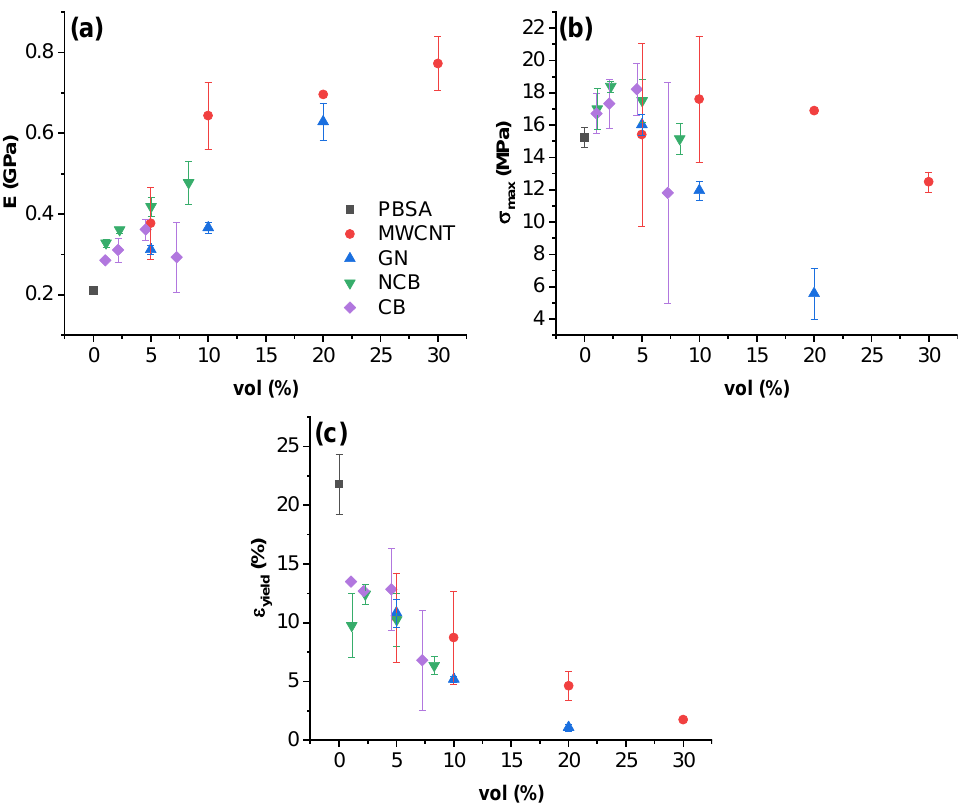
Figure 1. Tensile properties of PBSA/carbon nanoparticle composites: ( a ) elastic modulus, ( b ) tensile strength, and ( c ) yield elongation.